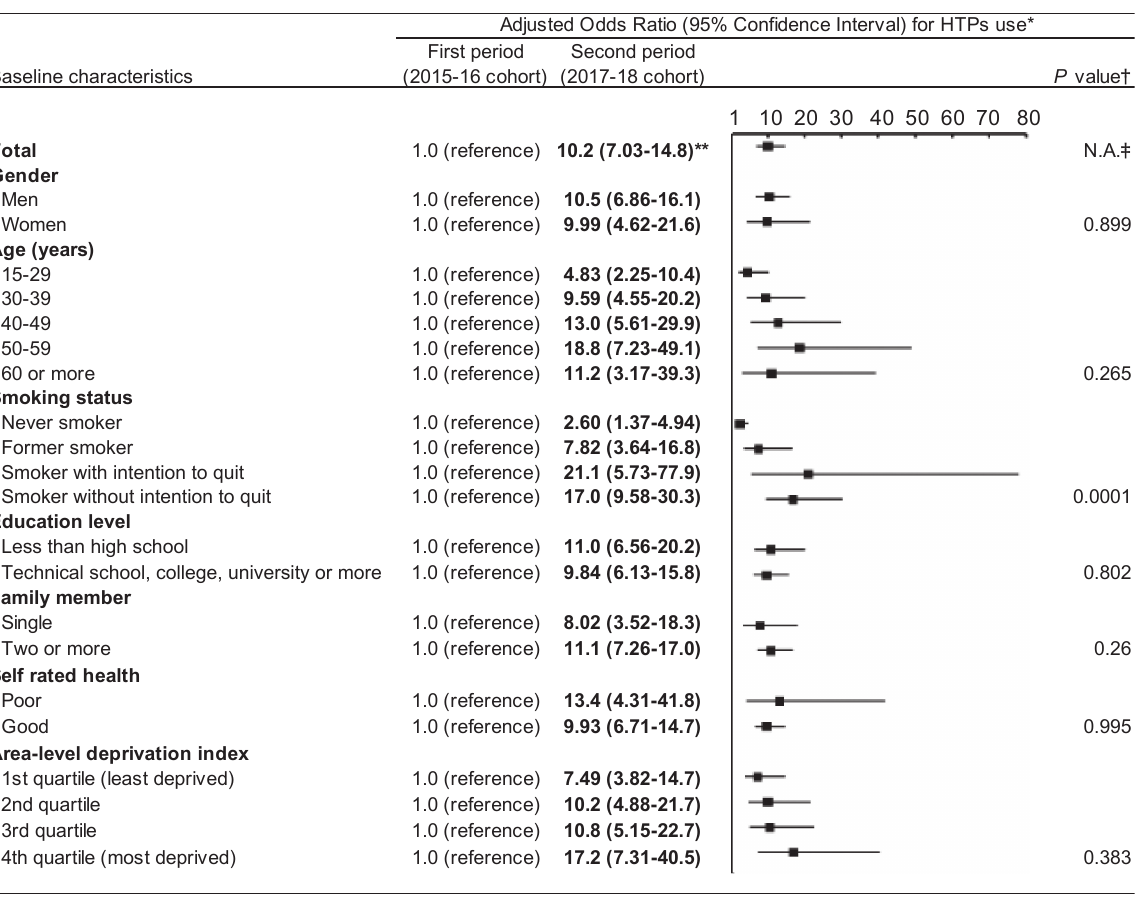
Fig. 2 Strati fi ed analysis of logistic regression with a generalized estimating equation modi fi cation for heated tobacco products Note: The fi gure shows result for 2017 – 18 cohort (second period) compared to 2015 – 16 cohort ( fi rst period). HTPs use means HTP use prevalence in 2016 for the fi rst period and 2018 for the second period.; * Logistic regression with a generalized estimating equation modi fi cation, adjusting for all listed variables in addition to the cohort variable (before or after); ** Boldface indicates statistically signi fi cance (p < 0.05); † P values for the interaction term between the period and each variable. ‡ N.A., not